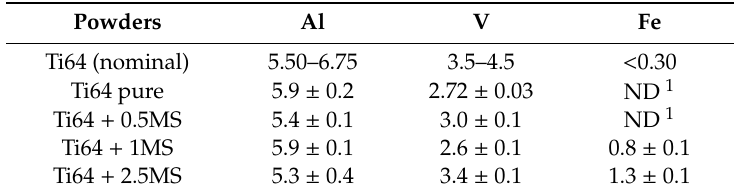
Table 2. Comparison of wt.% concentrations (mean values and standard deviations) of major Ti64 (Ti, Al) and contaminant (Fe) elements.